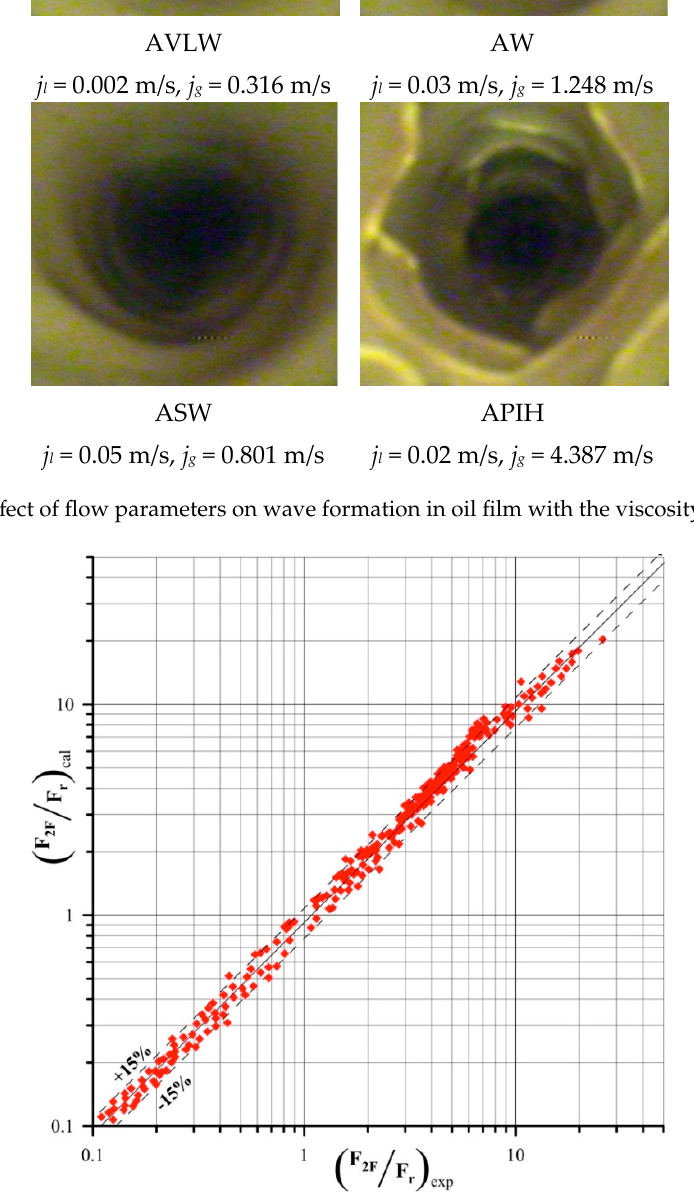
Figure 21. Representation of calculated interfacial surface based on Equation (22).